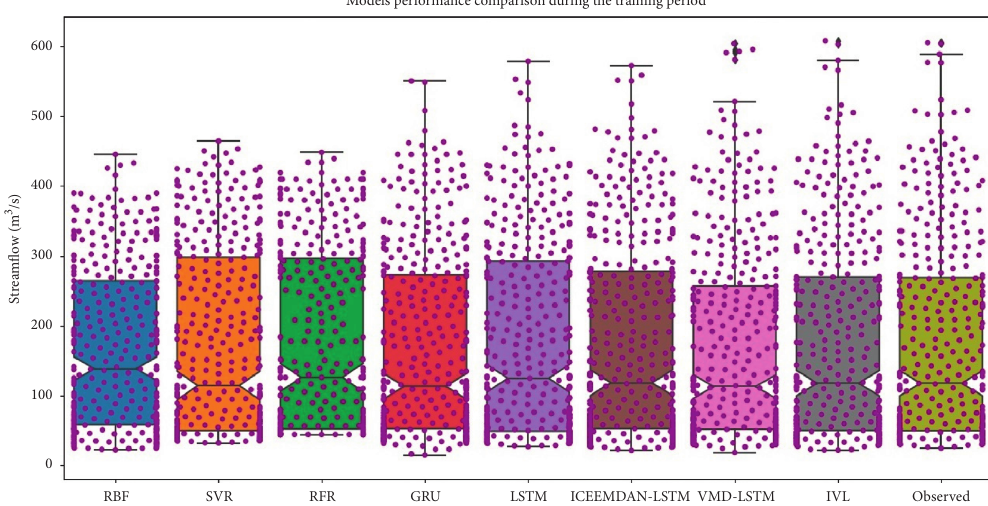
Models performance comparison during the training period